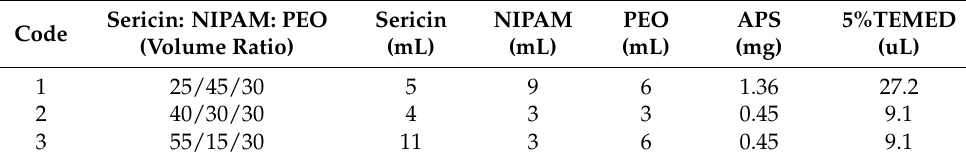
Table 1. The formulations of the interpenetrating network blending spinning solution.